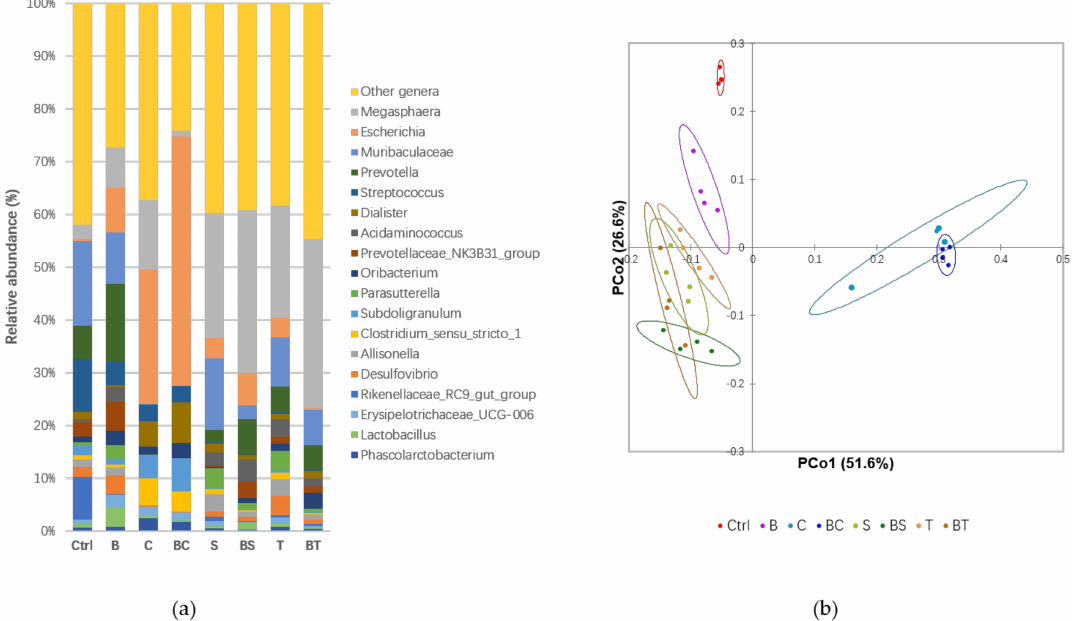
Figure 3. Microbial diversity and abundance were altered by inclusion of lipids in the model diet. Relative abundance of most abundant ( > 1%) microbial genera ( a ) and weighted UniFrac-principal coordinate analysis (PCoA) analysis of beta diversity among all profiled samples ( b ). Di ff erent groups are denoted by colours as shown in the legend. Abbreviations: Ctrl (negative control with faeces only), B (black carrot only), C (coconut oil), BC (black carrot and coconut oil mixture), S (sunflower oil), BS (black carrot and sunflower oil mixture), T (tallow), and BT (black carrot with tallow